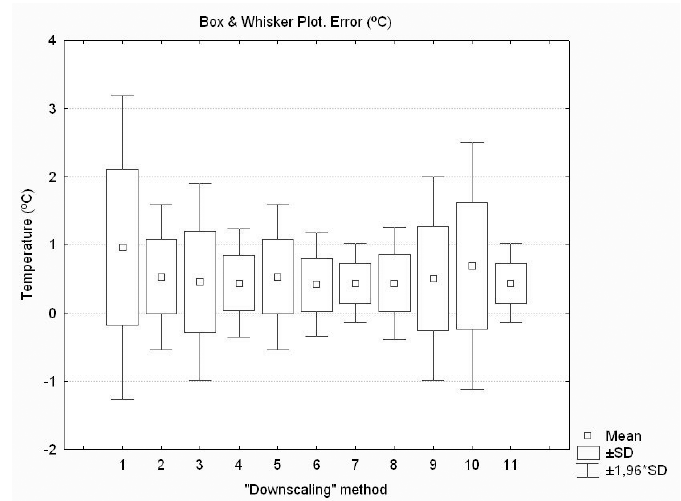
Figure 2. Estimated mean absolute errors (MAE) for temperature using different deterministic and geostatistical methods. The 11 methods used were: (1) Inverse Distance Weighting; (2) Global Polynomial Interpolation; (3) Local Polynomial Interpolation; (4) Kriging; (5) Cokriging (altitude); (6) Cokriging (altitude, forest area); (7) Cokriging (altitude, aspect); (8) Cokriging (altitude, slope,